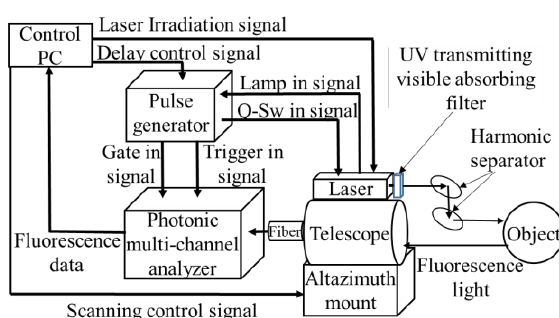
Fig. 1 Block diagram of the LIFS lidar. Operational parameter of each device and the flow of signals and data are shown. Table Ⅰ Specifications of the LIFS